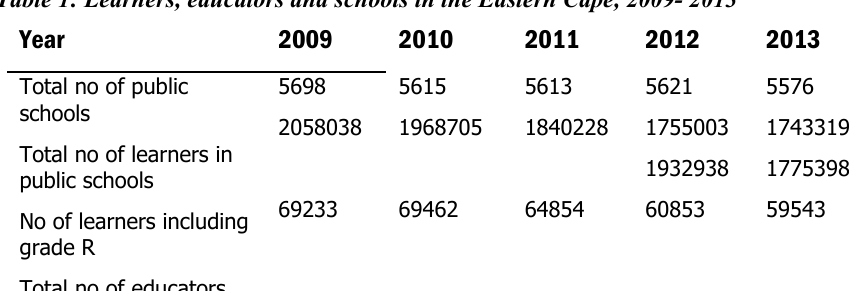
Table 1: Learners, educators and schools in the Eastern Cape, 2009-